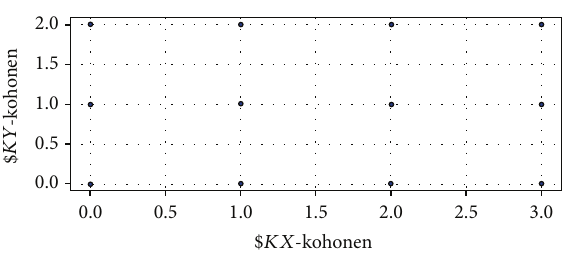
Figure 3: Twelve clusters generated by SOM